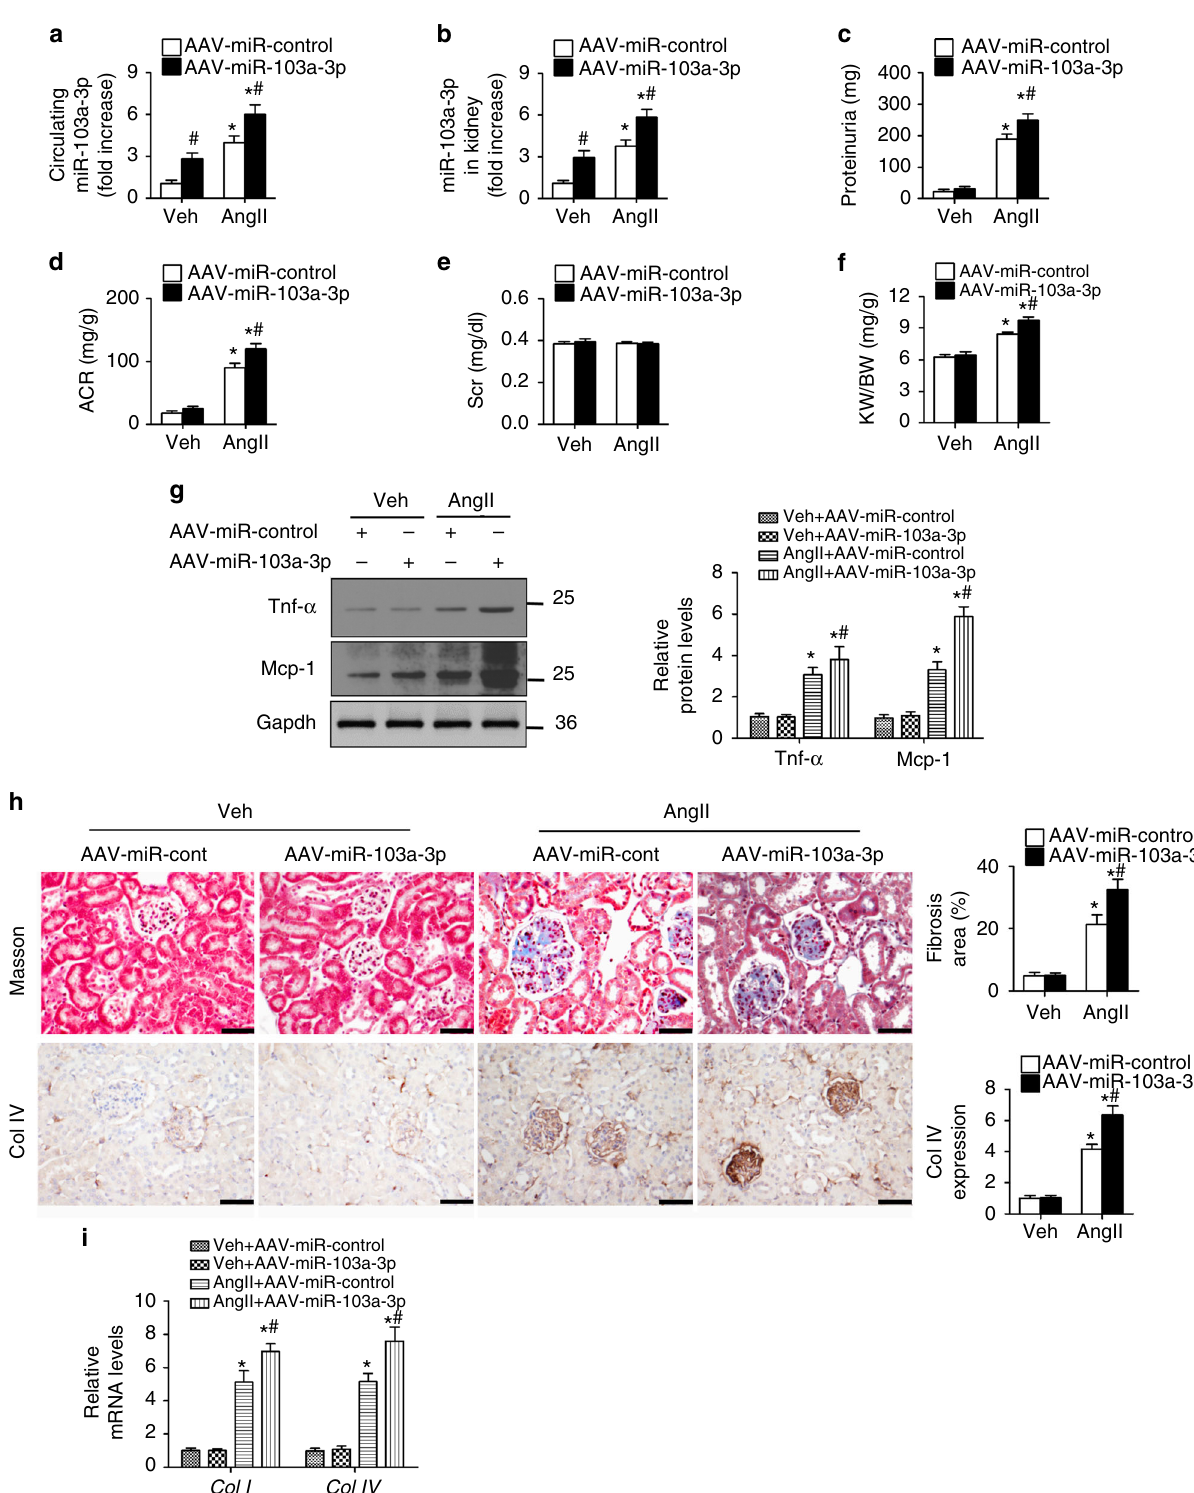
Fig. 2 Overexpression of miR-103a-3p promotes AngII-induced renal injury. Mice ( n = 6 per group) transfected with AAV-miR-103a-3p or AAV-miR- control were infused with a vehicle control (Veh) or AngII (1 mg kg − 1 d − 1 ) for 4 weeks. a Serum miR-103a-3p levels as determined by qRT-PCR. b Kidney tissue miR-103a-3p levels. c Albumin excretion rate. d Albumin/creatinine ratio (ACR). e Serum creatinine levels. f Kidney weight to body weight ratio (KW/BW). g Western blot analysis of Mcp-1 and Tnf- α levels in the kidneys. h Representative images of trichrome staining and immunohistochemical staining of collagen type IV (Col IV) in the kidneys (scale bar = 50 µ m). i Collagen type I and IV mRNA levels as measured using qRT-PCR. For all experiments, n = 6 per group; * p < 0.05 relative to vehicle control; # p < 0.05 relative to AAV-miR-Control (Student ’ s t -test). The corresponding source data are available in the Source Data fi